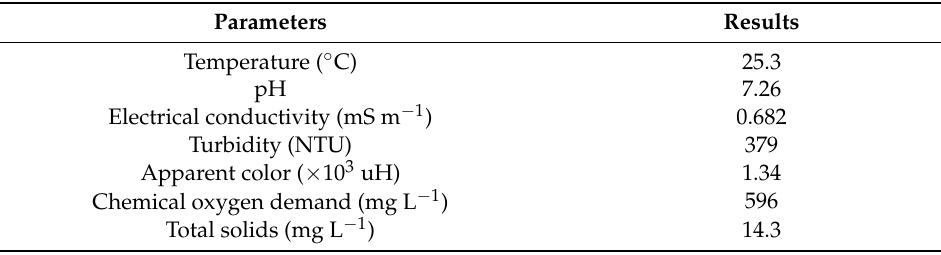
Table 1. Physical–chemical parameters of the raw wastewater.